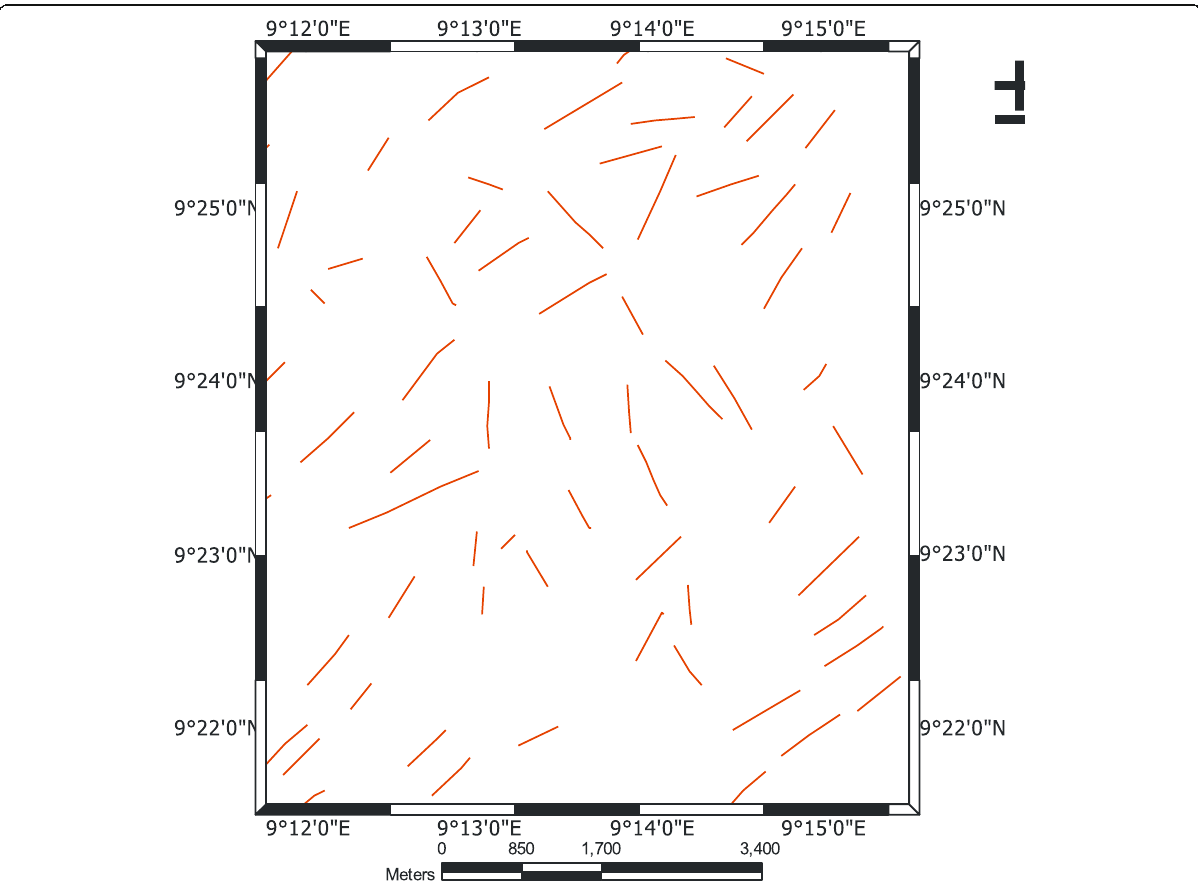
Fig. 14 Lineament density of the area with major trend in the NNE – SSW